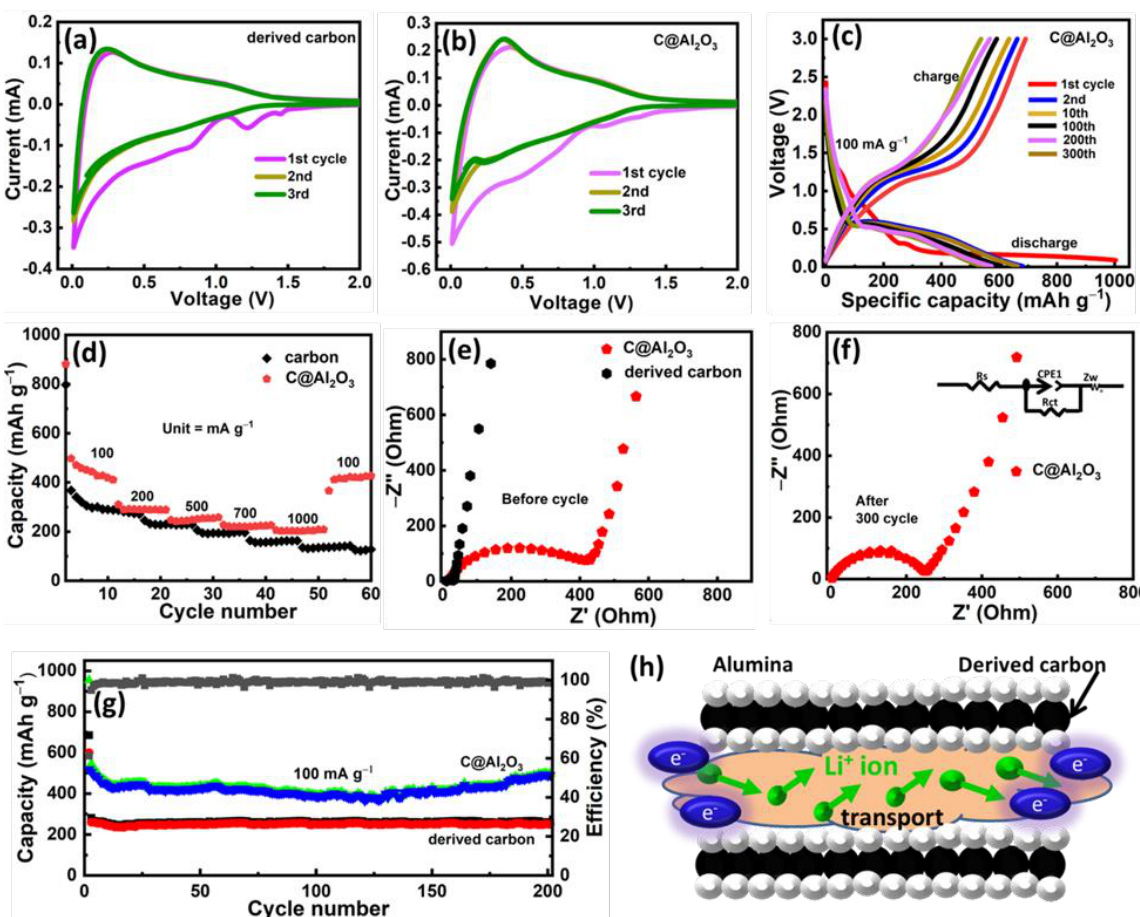
Figure 5. Electrochemical performances. ( a , b ) CVs of pure carbon and C@Al 2 O 3 , ( c ) charge/discharge profile of derived C@Al 2 O 3 , ( c ) charge-discharge vs. cyclic number of carbon C@Al 2 O 3 sample